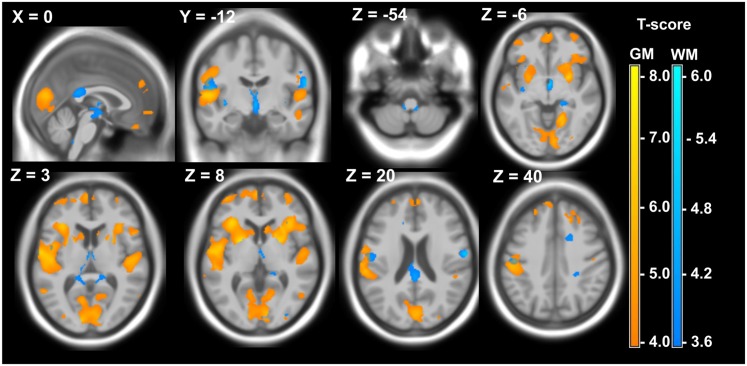
Local atrophy of GM (yellow) and WM (blue) in 15 DM2 patients compared to 28 healthy controls.Voxelwise multiple regression analysis with group and age as covariates. Age was used as a covariate of no interest. Areas with adjusted p at cluster level < 0.05 after FWE correction are shown; X,Y,Z: MNI-coordinates: negative X-values reflect left side and positive X-values right sided location.